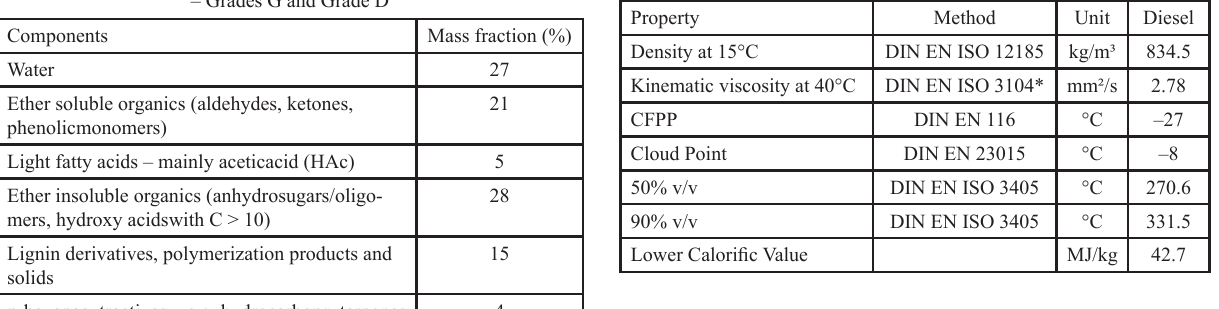
Table 2. Component Fractions of Pyrolysis Oil meeting the requirements of ASTM D7544-12 Standard Specification for Pyrolysis Liquid